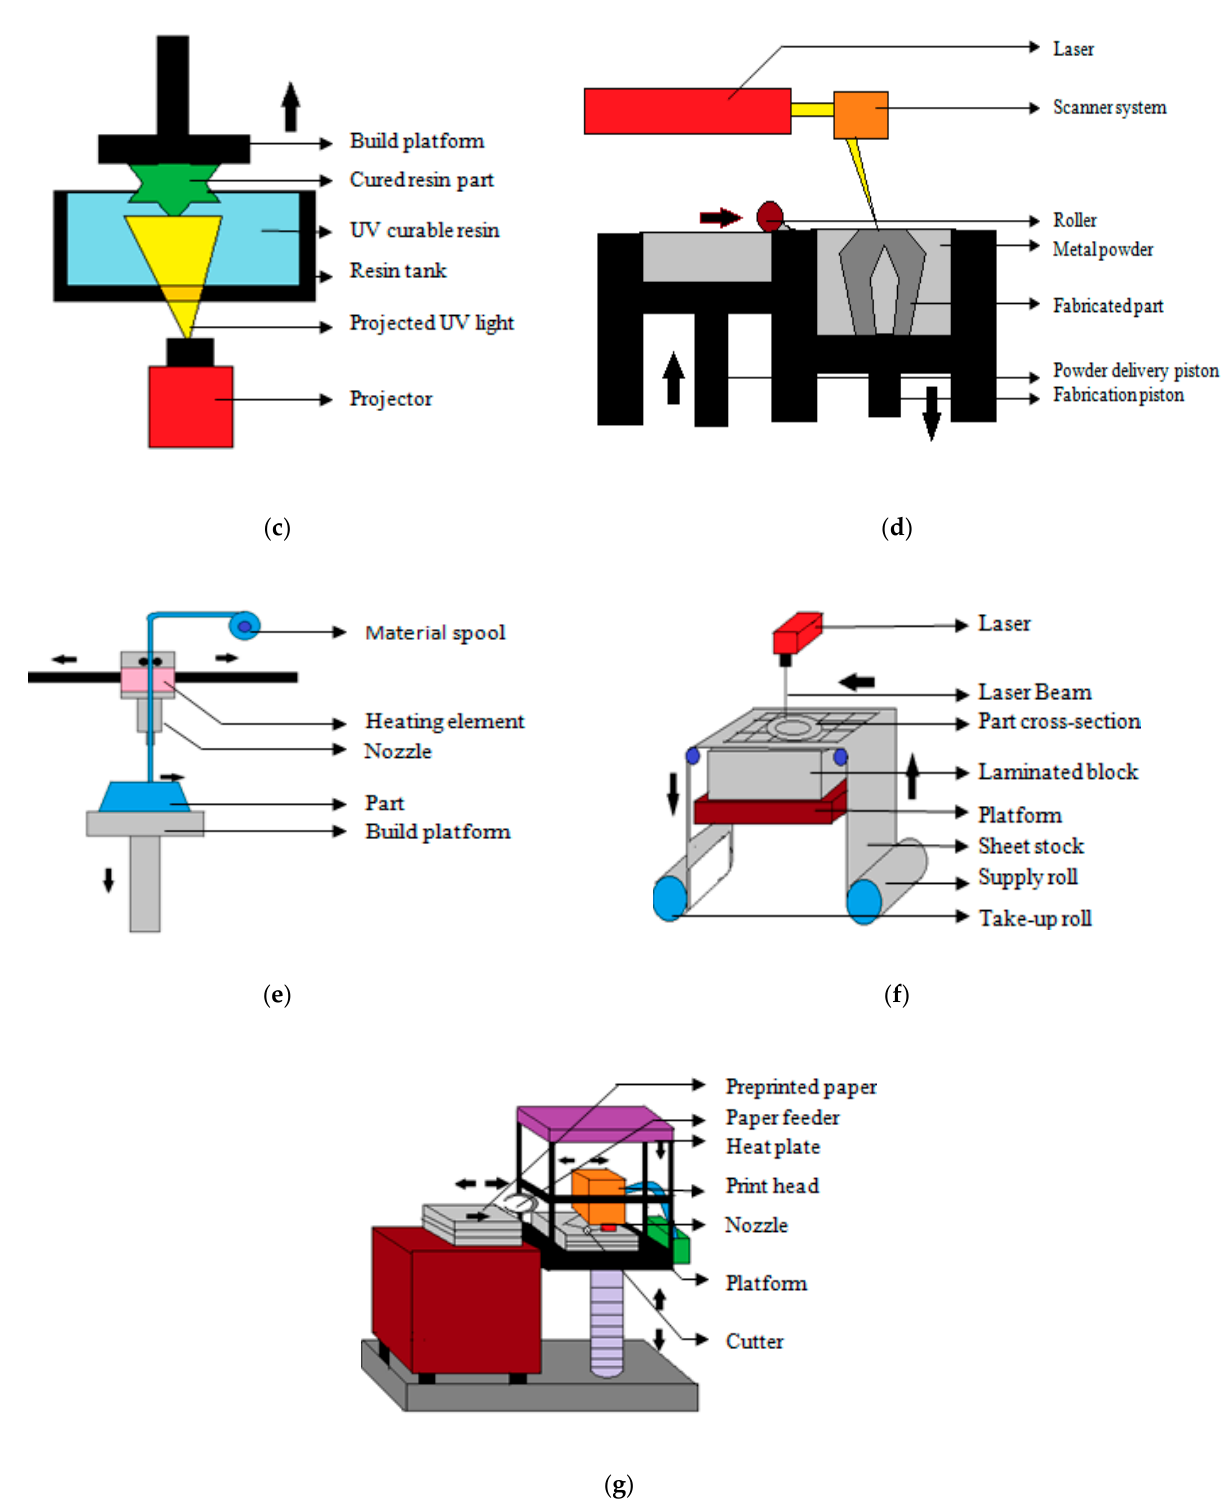
Figure 4. Schematic representation of the most popular additive manufacturing processes used for fabrication of polymer products ( a ) polyjet printing; ( b ) stereolithography (SLA); ( c ) direct light processing (DLP); ( d ) selective laser sintering (SLS); ( e ) fused deposition modeling (FDM); ( f ) laminated object manufacturing (LOM); ( g ) selective deposition modeling (SDM).